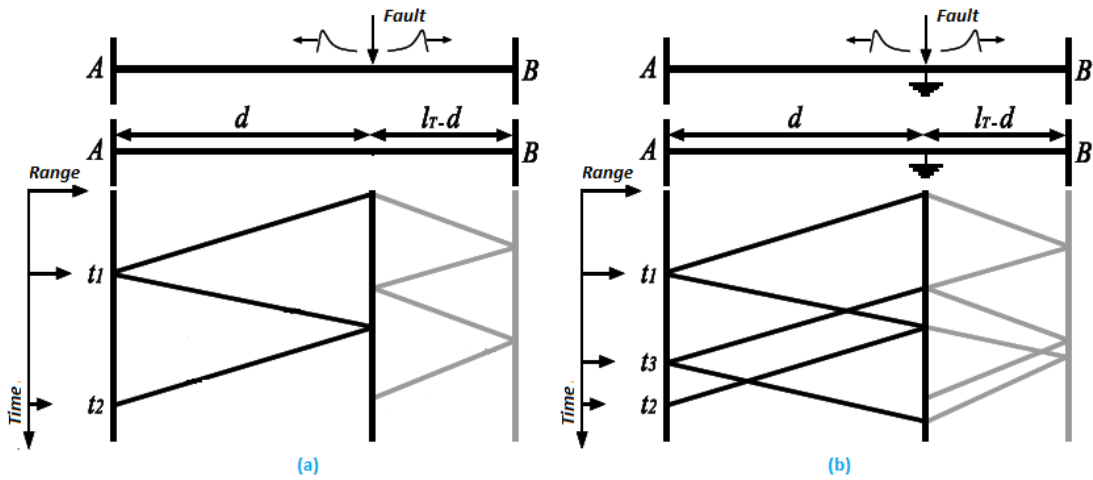
Figure 2. Peak propagation time. A : Monitoring terminal; B opposite terminal; d : fault distance; l T : line length; t 1 and t 2 : propagation times of wave fronts; t 3 : refracted wave propagation time. ( a ) Ground fault; ( b ) Fault without ground